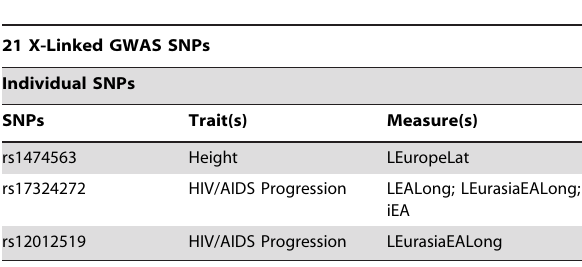
Table 5. Individual SNPs that were significant for at least one delta, F st , LLC, or iHS measure in the X chromosome